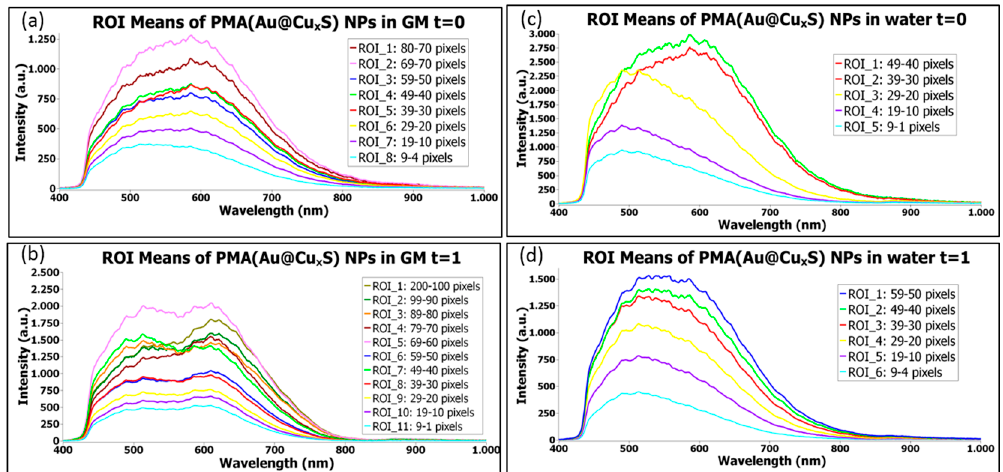
Figure 6. Temporal tracking AuCuS NPs spectral changes induced by the solvent’s viscosity. HEDFM tracked the scattering profiles of NPs dispersed in water (non-viscous medium) and cell GM (viscous medium) over time. The plots represent the mean spectral profiles of different regions of interest (ROIs) containing the spectra of particles with the same pixel size. The number of pixels associated with one particle forms its pixel size. We sorted the particle populations by pixel size at different time points, i.e., t = 0 and t = 1, corresponding to the time of immediate addition of the solvent and the time after 2–3 months of storage, respectively in GM ( a ) and ( b ); and water ( c ) and ( d ). In the SI (Figure S5), the evolution of the NPs after 8 months in GM is also shown [8].